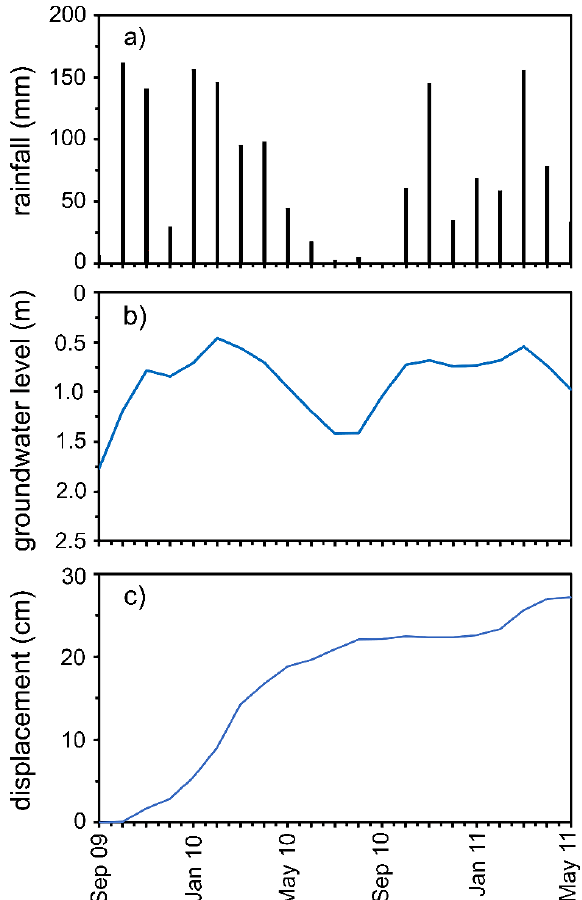
Figure 6. Available measurements from September 2009 to May 2011: ( a ) rainfall, ( b ) groundwater level, ( c ) displacement.